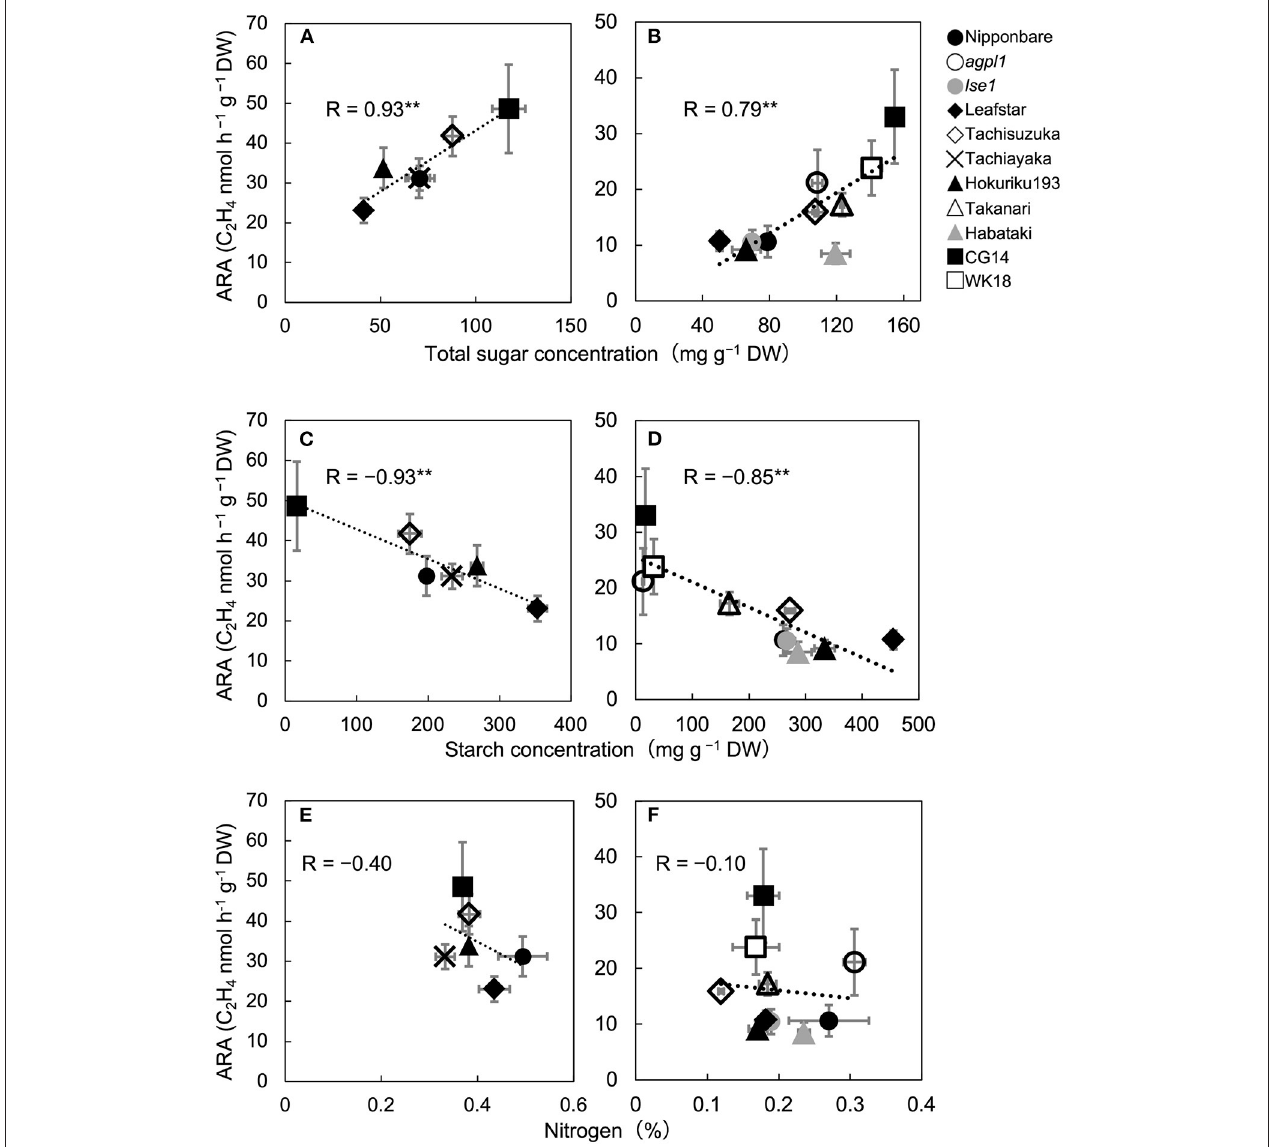
FIGURE 1 | Relationship between acetylene reduction activity (ARA) and total sugar (sucrose and glucose) concentration of stem in six rice varieties in 2017 (A) and 10 rice genotypes in 2018 (B) , correlation between ARA and starch concentration in 2017 (C) and 2018 (D) , and correlation between ARA and nitrogen concentration in 2017 (E) and 2018 (F) , at heading stage in the field experiment. The data for non-structural carbohydrates (glucose, sucrose, and starch) were used from Table 2 . Data are means ± SE ( n = 3 in 2017 and n = 4 in 2018). **indicates significance at P =